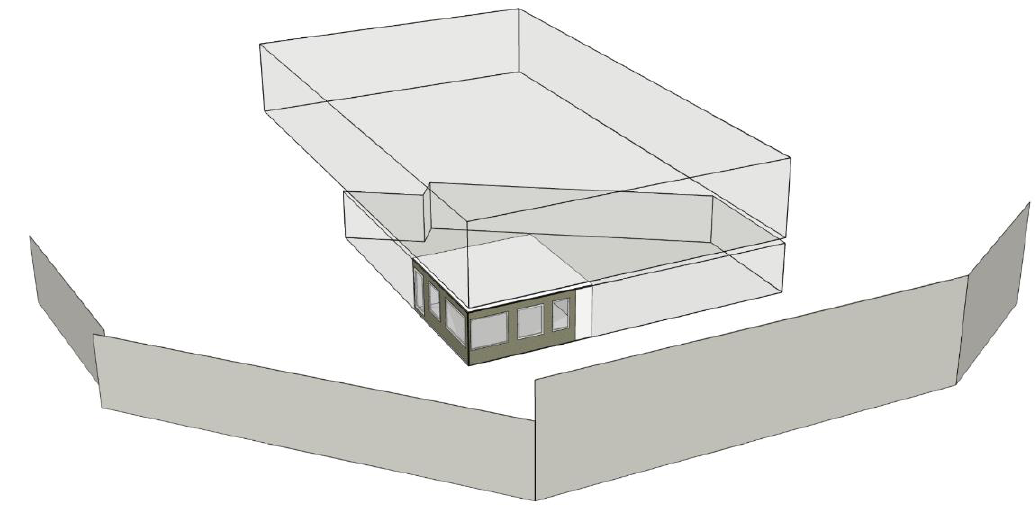
Figure 11. Implemented building model in IDA-ICE.